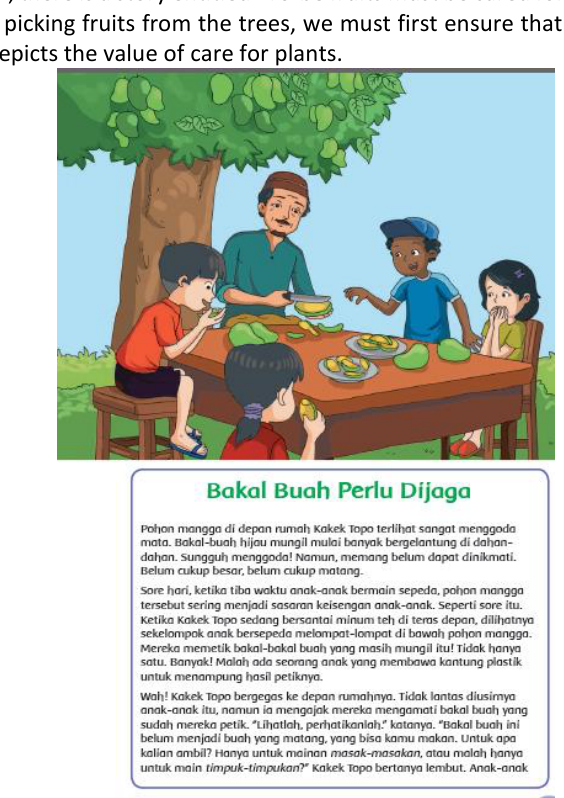
Figure 12: The story “To-be fruits must be cared